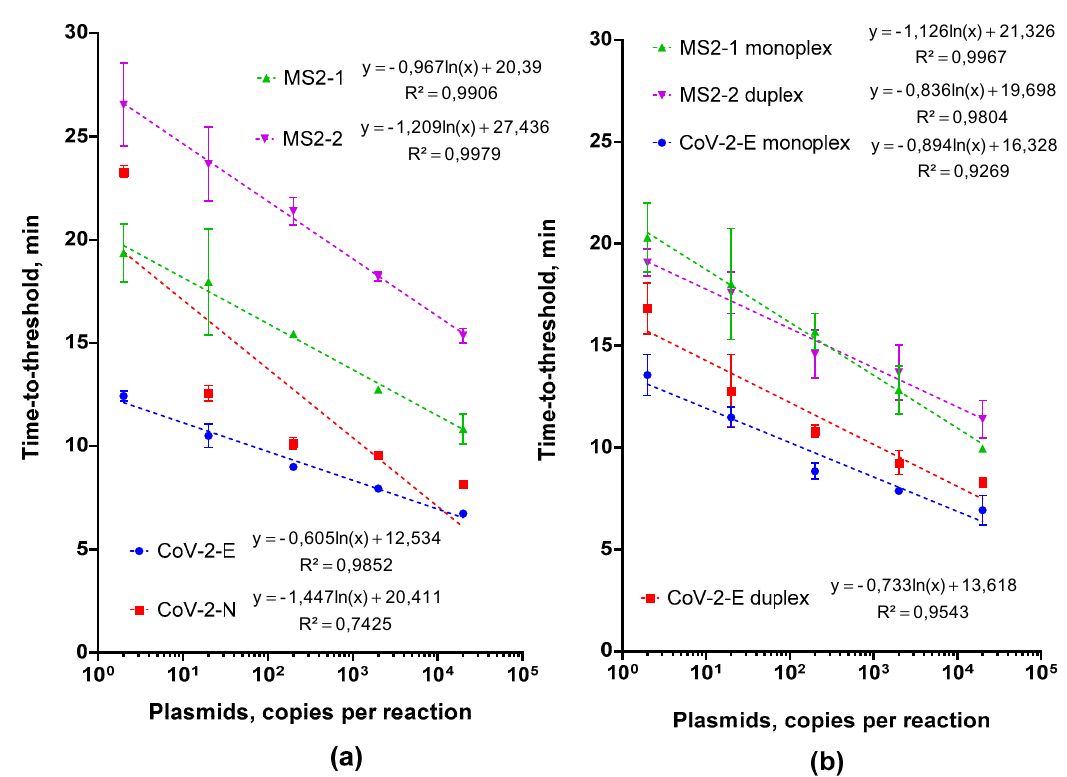
Figure 1. ( a ) LAMP with plasmids and different primers for SARS-CoV-2 and MS2; ( b ) LAMP with standard plasmids, monoplexes SARS-CoV-2, MS2 and duplex primer set MS2-SARS-CoV-2-E. Each primer set is marked by the color specified in the legend. Time-to-threshold (Tt) values are presented on the X-axis, and the amount of template per reaction on the Y-axis. Each run was triplicated; error bars represent one SD.